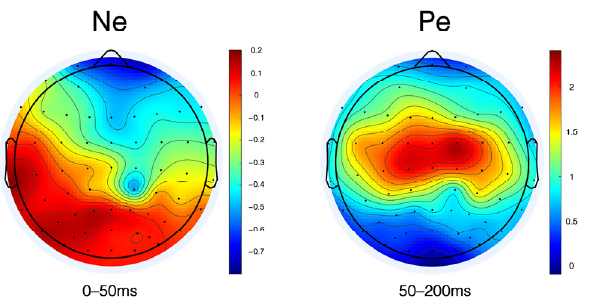
Figure 8. The grand scalp 2D topography map of Ne and Pe. The time window of the mean ampli- tudes of Ne was 0–50 ms, and the time window of the mean amplitudes of Pe was 50 − 200 ms. The color red means higher positive amplitudes, whereas the color blue means more negative ampli- tudes.